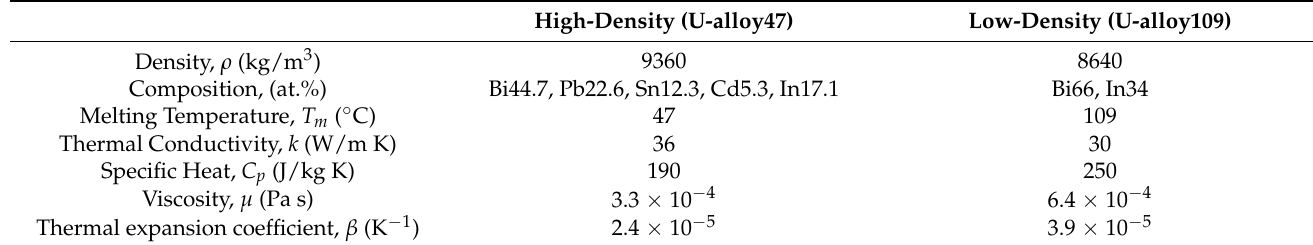
Table 2. Simulant material